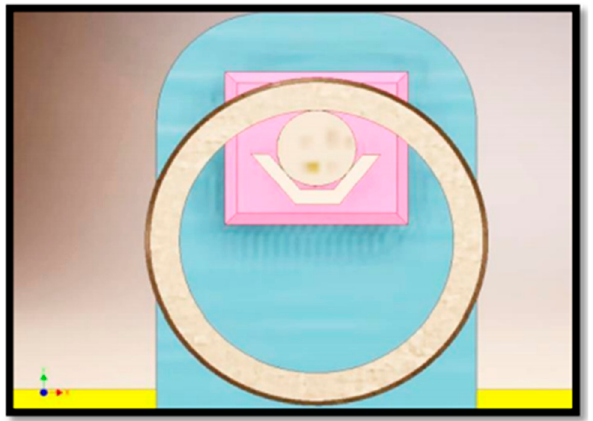
Figure 8. Current position of the parts on the central conductor.